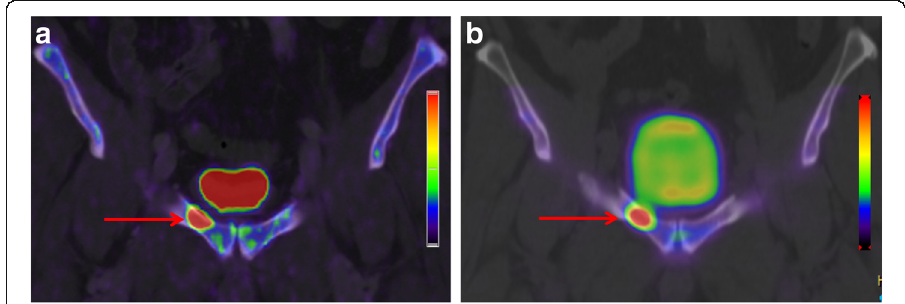
Fig. 2 Images of a 57 year old male with a two years history of prostate cancer (Gleason grade group 5, T2a, N1, M0), in androgen deprivation therapy, and referred for bone imaging due to increasing prostate specific antigen (WB-MRI images from the same patient are shown in Fig. 3). a - b NaF-PET/CT images and WB-SPECT/CT images demonstrate focal tracer uptake in the right superior pubic ramus highly suspicious of